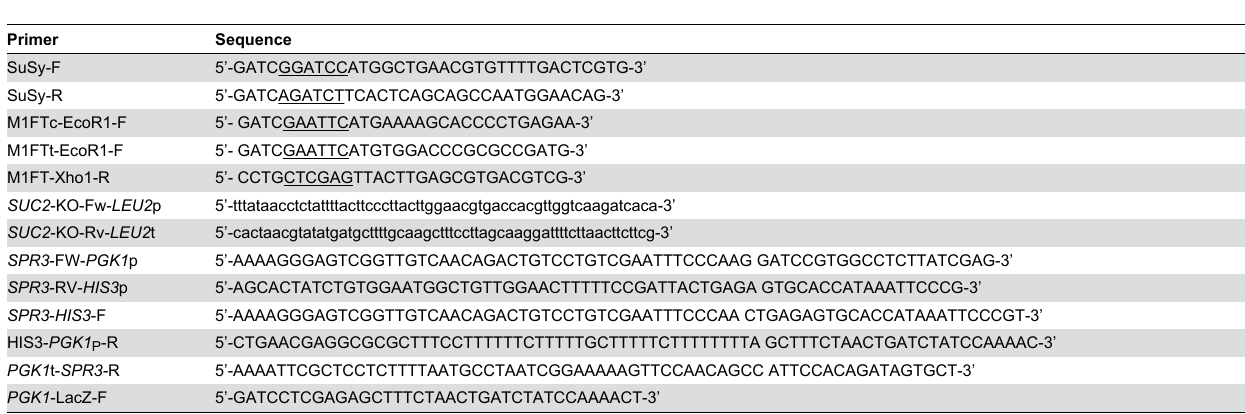
Table 2. Primers used in this